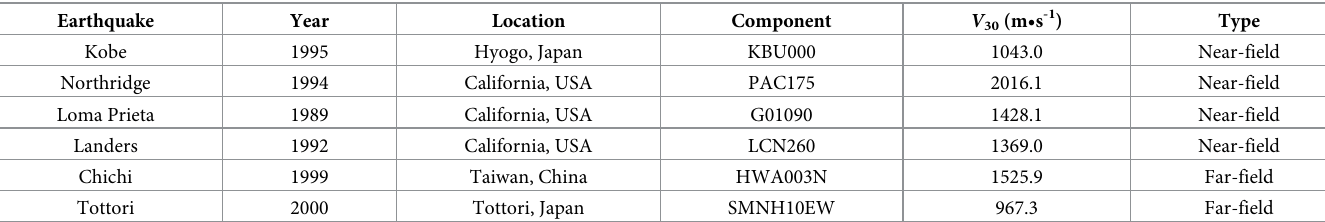
Table 1. Information of ground motion records.